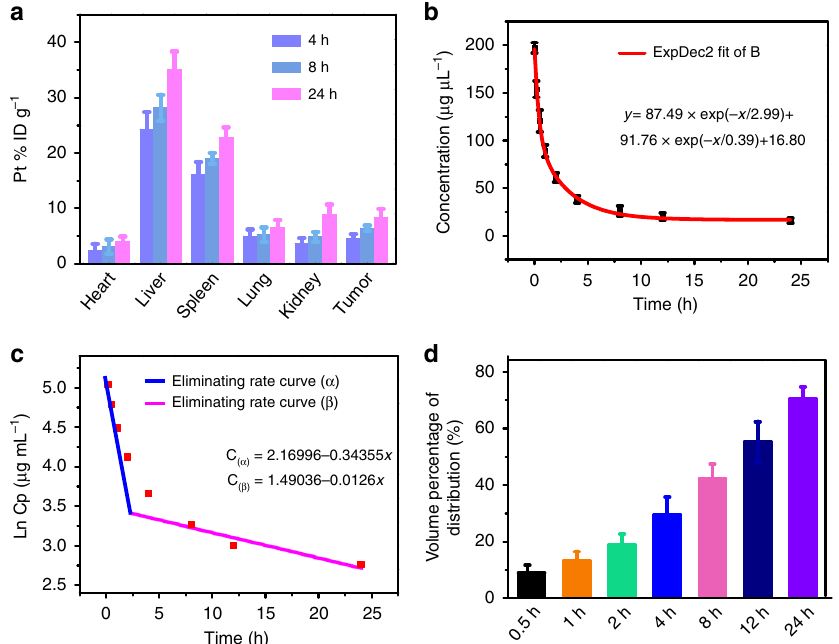
Fig. 7 The pharmacokinetics studies of MnO 2 @PtCo nano fl owers. a The biodistribution of nano fl owers in main organs and tumors at different time points. b The blood circulation curve of intravenously injected nano fl owers. c The eliminating rate curve of nano fl owers from the blood circulation curve according to the In(concentration) – T relationship. d The apparent volume percentage of distribution ( V d %) of intravenously injected nano fl owers. Data were presented as mean ± s.d. ( n =